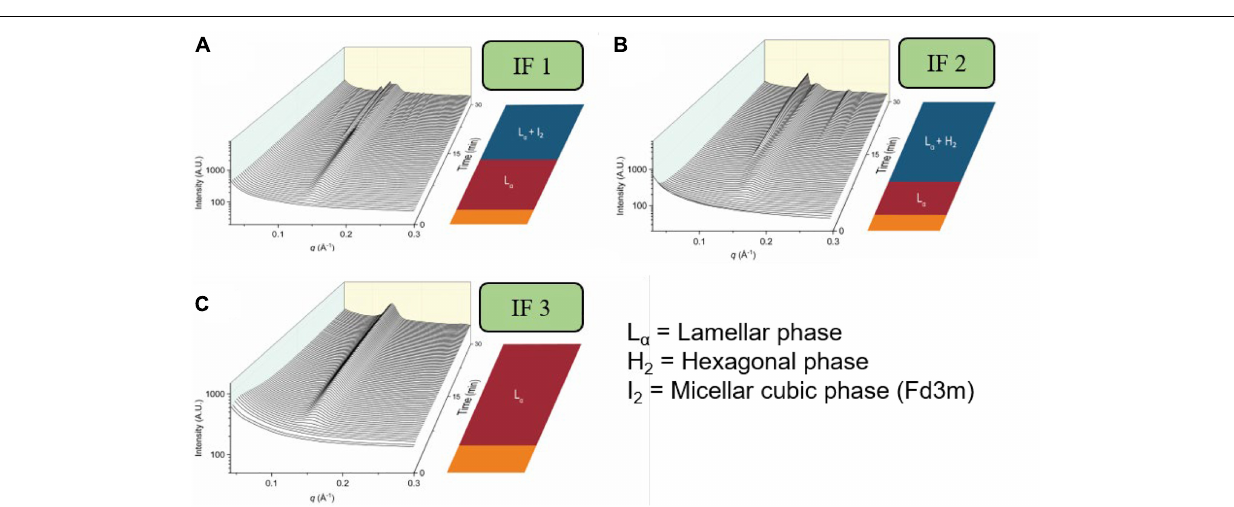
FIGURE 13 | The formation of mesophases during the digestion of various brands of infant formula. Scattering profiles during the digestion of three brands of infant formula are adapted and reproduced from Pham et al. (2020). (A) represents the scattering profiles during the digestion of infant formula 1 (IF 1), (B) represents the scattering profiles during the digestion of infant formula 2 (IF 2), and (C) represents the scattering profiles during the digestion of infant formula 3 (IF